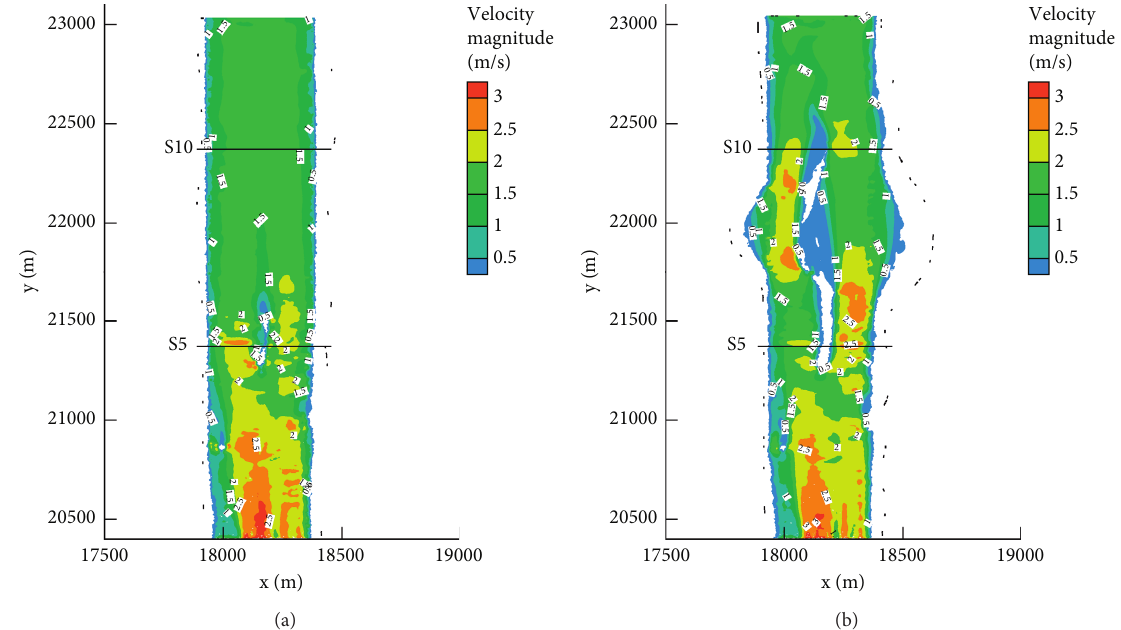
Figure 8: Comparisons of the velocity of flood flow before and after river reconstruction for a 100-year flood. (a) Before reconstruction. (b) After reconstruction.